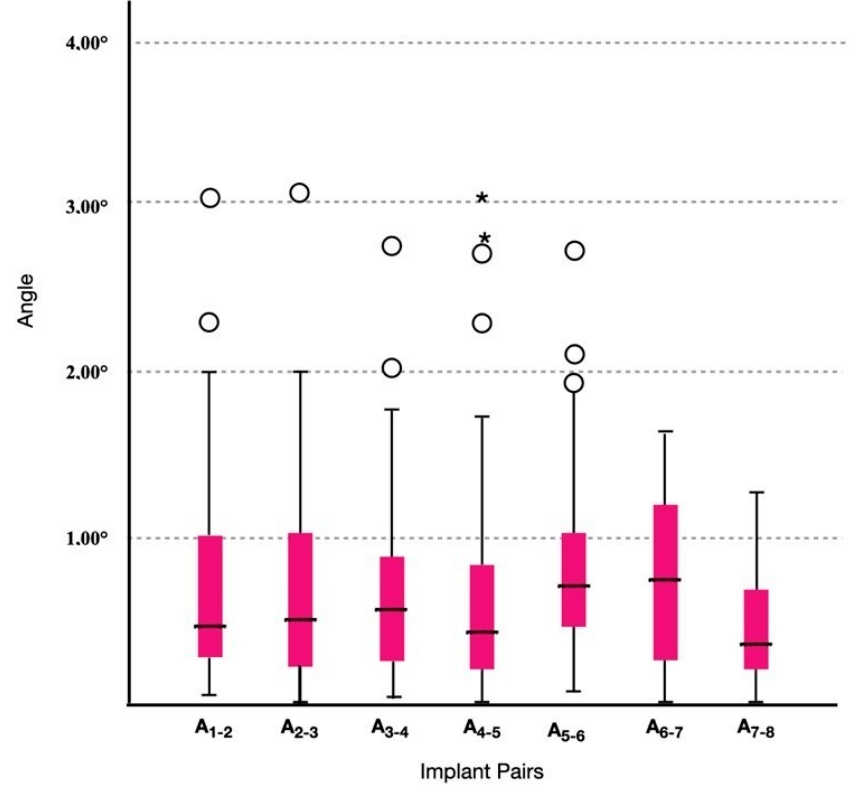
state outliers. (cid:35)